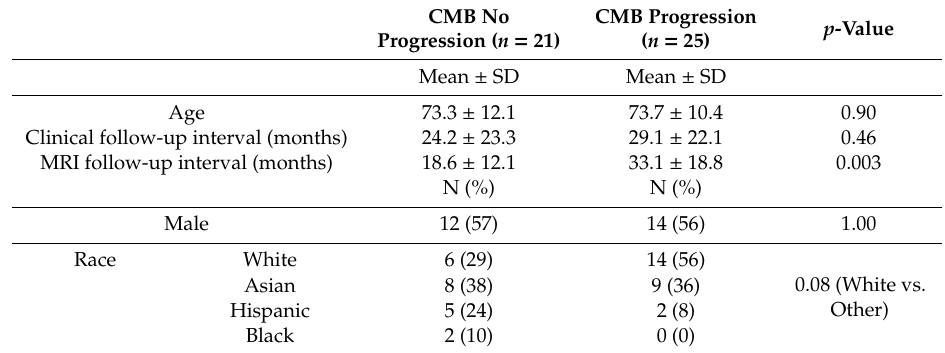
Table 1. Demographic factors and stroke events in 46 patients with and without cerebral microbleed (CMB)